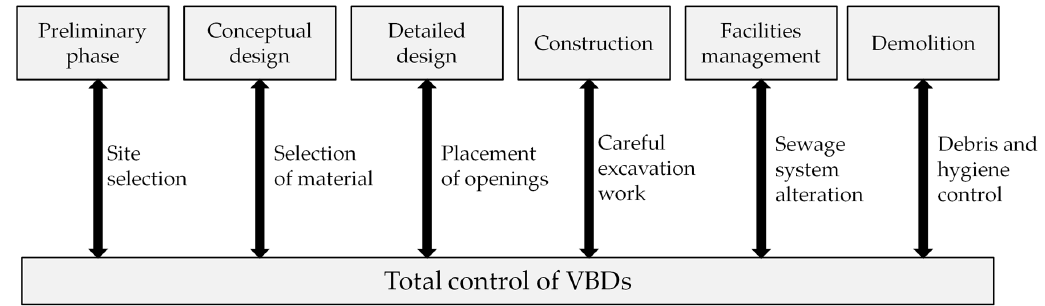
Figure 8. A decision support system for built environment professionals.